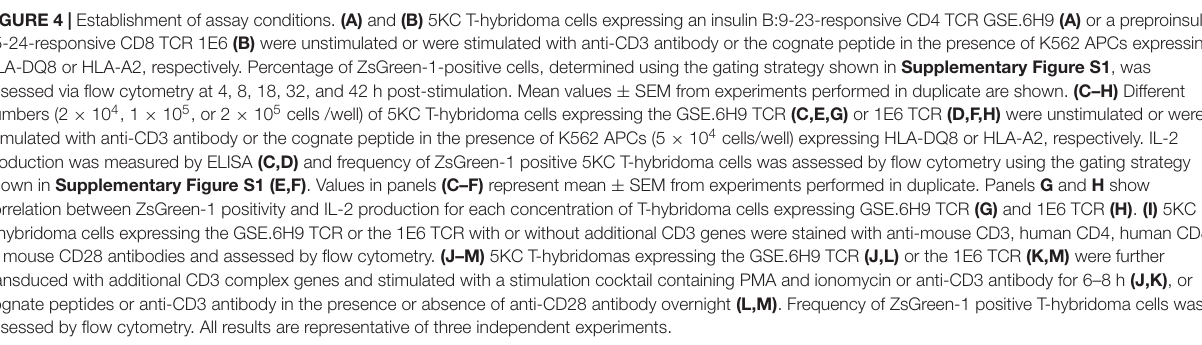
FIGURE 4 | Establishment of assay conditions. (A) and (B) 5KC T-hybridoma cells expressing an insulin B:9-23-responsive CD4 TCR GSE.6H9 (A) or a preproinsulin 15-24-responsive CD8 TCR 1E6 (B) were unstimulated or were stimulated with anti-CD3 antibody or the cognate peptide in the presence of K562 APCs expressing HLA-DQ8 or HLA-A2, respectively. Percentage of ZsGreen-1-positive cells, determined using the gating strategy shown in Supplementary Figure S1 , was assessed via flow cytometry at 4, 8, 18, 32, and 42 h post-stimulation. Mean values ± SEM from experiments performed in duplicate are shown. (C–H) Different numbers (2 × 10 4 , 1 × 10 5 , or 2 × 10 5 cells /well) of 5KC T-hybridoma cells expressing the GSE.6H9 TCR (C,E,G) or 1E6 TCR (D,F,H) were unstimulated or were stimulated with anti-CD3 antibody or the cognate peptide in the presence of K562 APCs (5 × 10 4 cells/well) expressing HLA-DQ8 or HLA-A2, respectively. IL-2 production was measured by ELISA (C,D) and frequency of ZsGreen-1 positive 5KC T-hybridoma cells was assessed by flow cytometry using the gating strategy shown in Supplementary Figure S1 (E,F) . Values in panels (C–F) represent mean ± SEM from experiments performed in duplicate. Panels G and H show correlation between ZsGreen-1 positivity and IL-2 production for each concentration of T-hybridoma cells expressing GSE.6H9 TCR (G) and 1E6 TCR (H) . (I) 5KC T-hybridoma cells expressing the GSE.6H9 TCR or the 1E6 TCR with or without additional CD3 genes were stained with anti-mouse CD3, human CD4, human CD8, or mouse CD28 antibodies and assessed by flow cytometry. (J–M) 5KC T-hybridomas expressing the GSE.6H9 TCR (J,L) or the 1E6 TCR (K,M) were further transduced with additional CD3 complex genes and stimulated with a stimulation cocktail containing PMA and ionomycin or anti-CD3 antibody for 6–8 h (J,K) , or cognate peptides or anti-CD3 antibody in the presence or absence of anti-CD28 antibody overnight (L,M) . Frequency of ZsGreen-1 positive T-hybridoma cells was assessed by flow cytometry. All results are representative of three independent